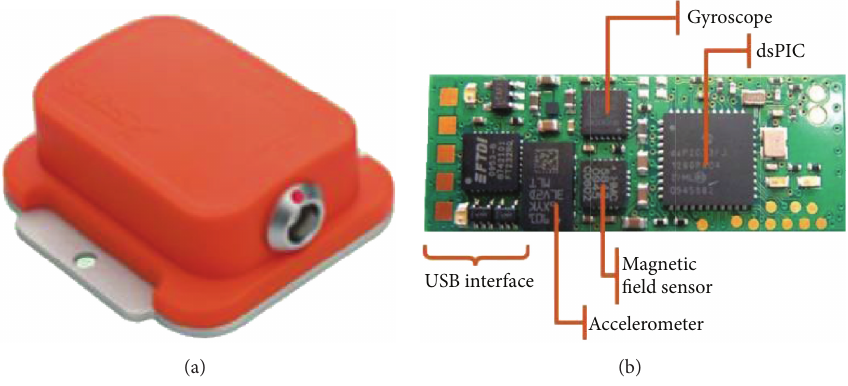
Figure 3: IMU sensor (a) and the prototype board